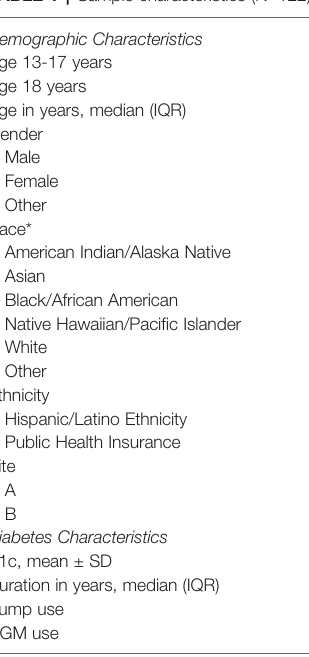
Family Relationships (n=37), School Changes (n=21), Personal TABLE 1 | Sample characteristics